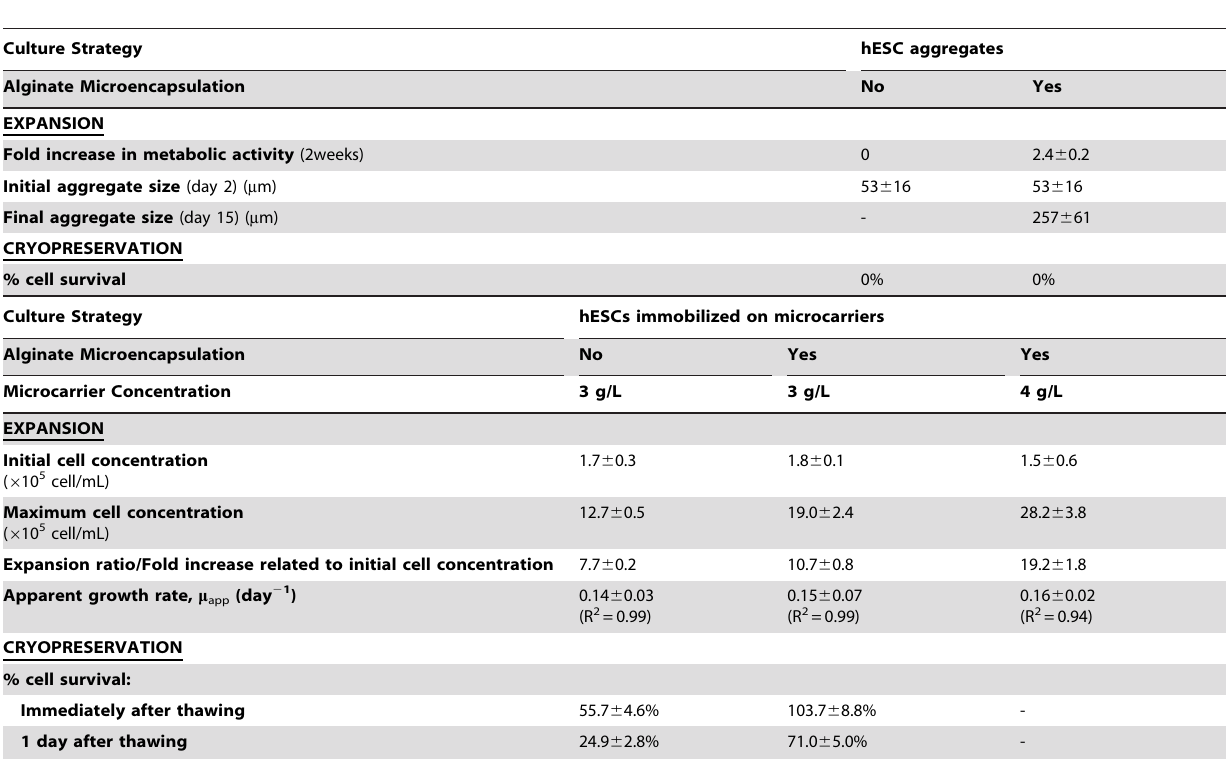
Table 1. Expansion and cryopreservation of encapsulated and non-encapsulated hESC cultures.